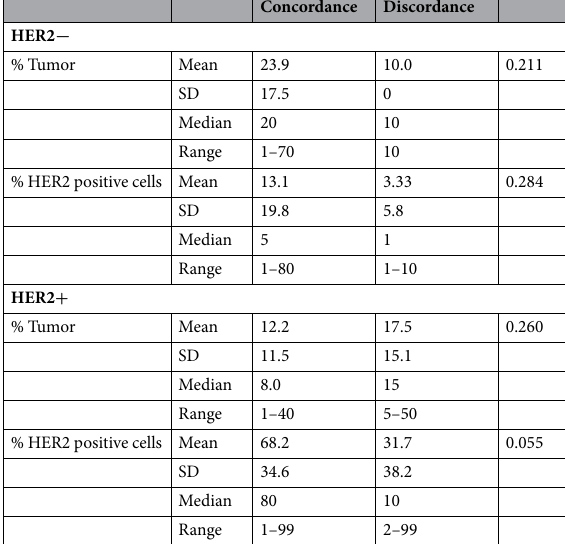
Table 4. Association of discordant results with tumor